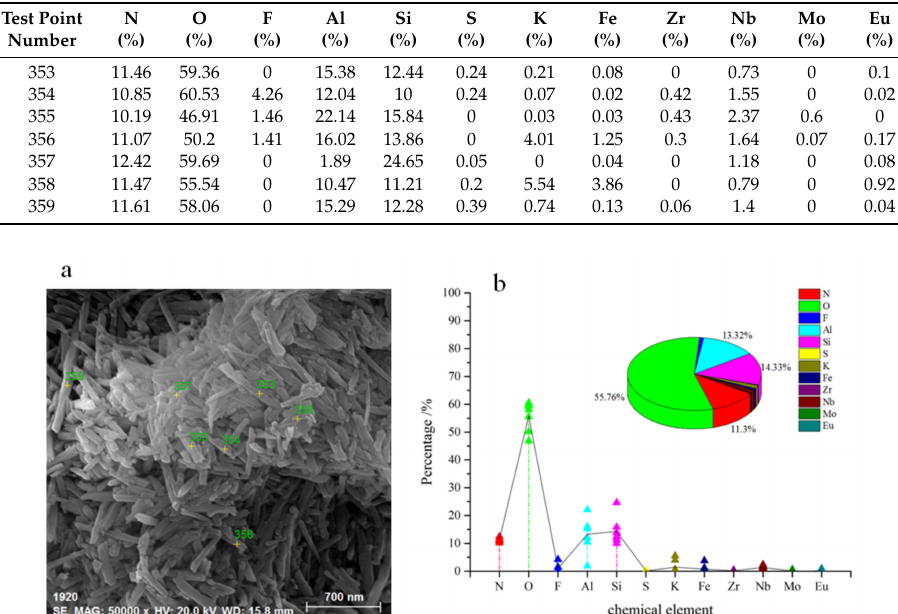
Figure 9. The result of the EDS test on microparticles. ( a ) The locations of test points on the specimens,